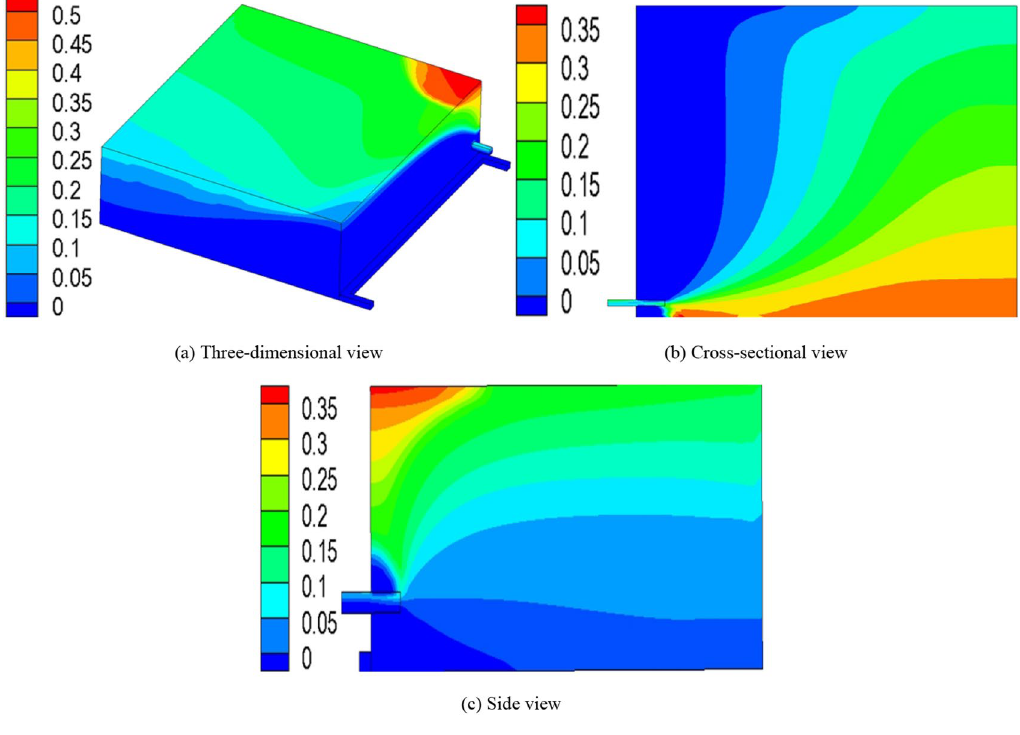
Figure 9. The drainage effect (FLUENT 16.0).